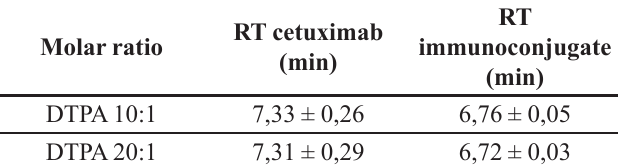
TABLE I - HPLC analysis of the unconjugated antibody and immunoconjugate. Retention time (RT) in minutes. Results expressed as mean ± SD. Chromatograms obtained by Shimadzu system